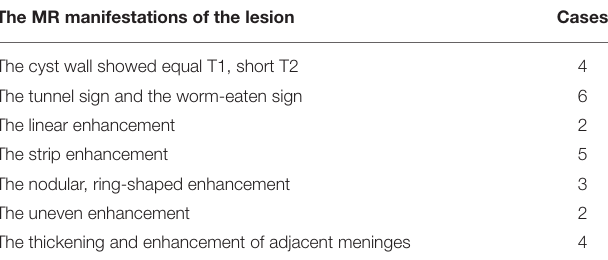
TABLE 2 | The MR manifestations of cerebral